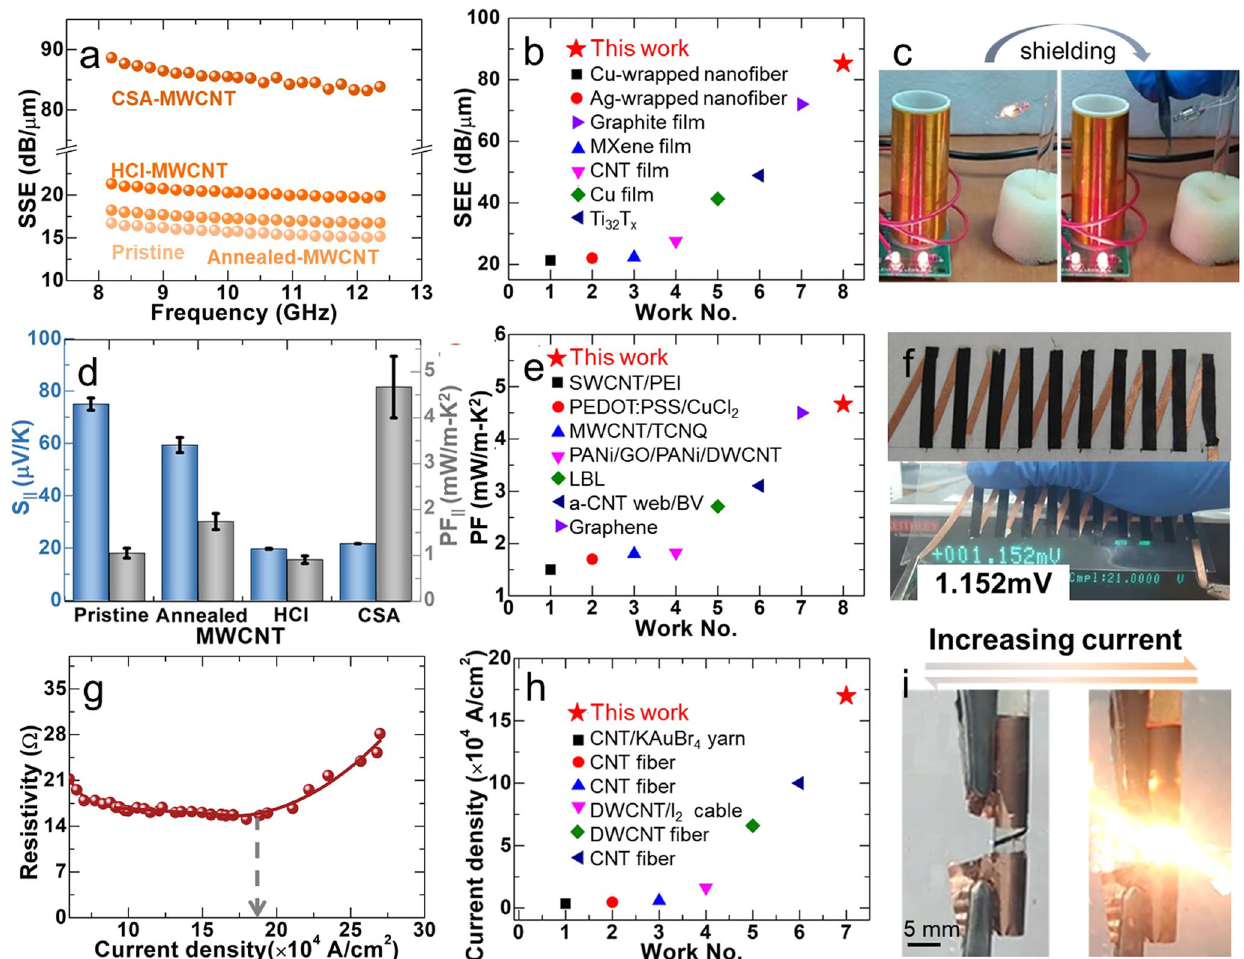
Fig. 2 | Electromagnetic interference shielding, thermoelectric, and ampacity properties characterization of MWCNT fi lms. a SSE of the MWCNT fi lms. b Comparison of the SSE(CSA-MWCNT) with that of state-of-the-art EMI shielding materials in the literature. c The optical images of a facial wireless power trans- mission device before and after shielding with CSA-MWCNT. d S || and PF || of the pristine-MWCNT, annealed-MWCNT, HCl-MWCNT, and CSA-MWCNT. e Comparison of the PF || (CSA-MWCNT) with that of p-type MWCNT-based fl exible